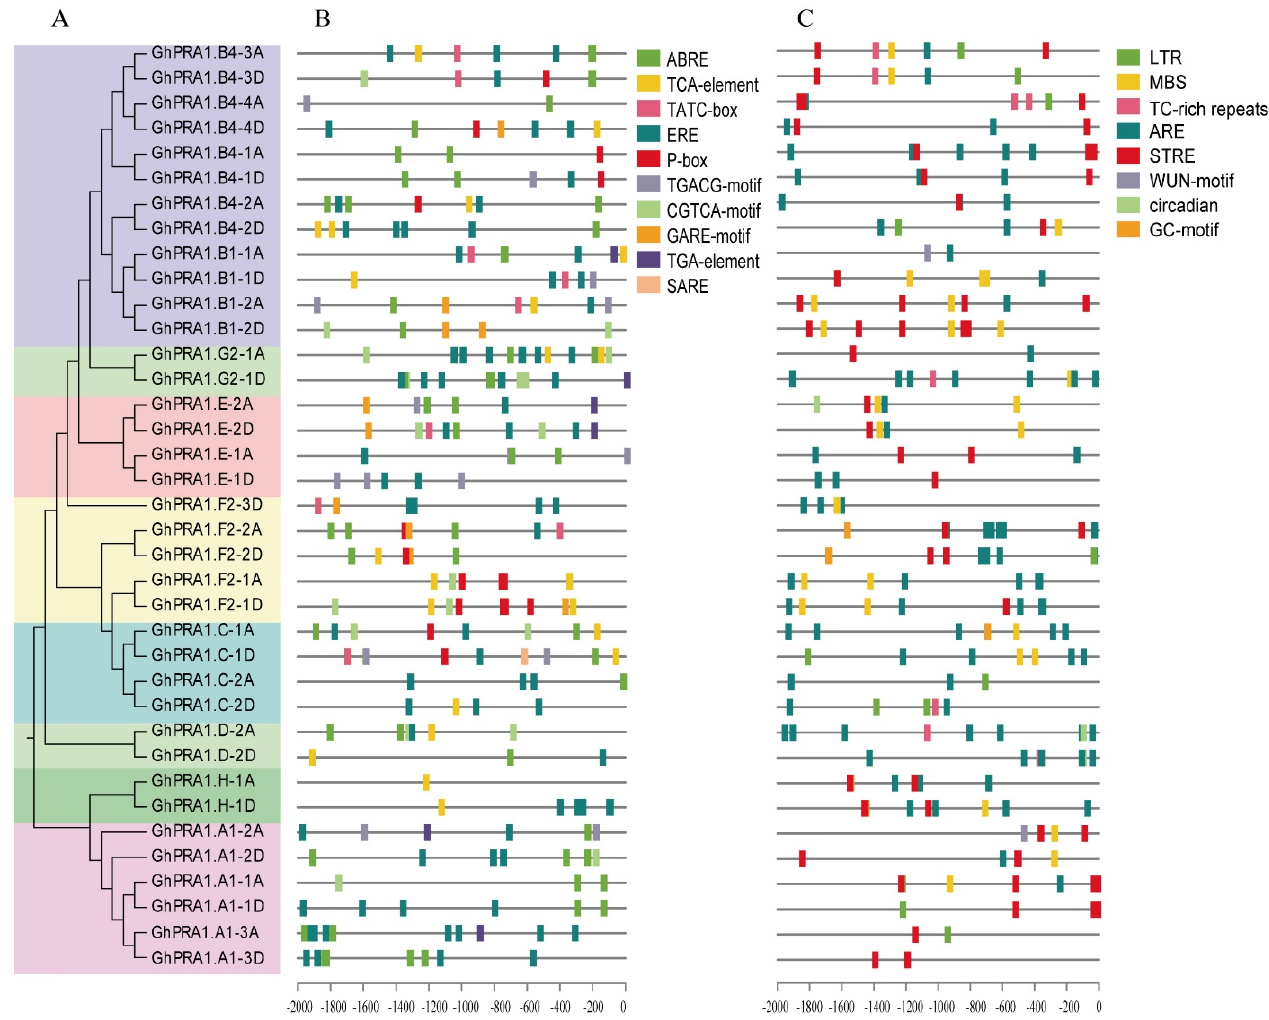
Figure 3. cis -elements in GhPRA1 promoter regions. ( A ) Phylogenetic tree of GhPRA1 proteins. ( B ) Hormone response elements. ABRE, abscisic acid response element; P-box; TATC box; GARE motif, gibberellin response element; TCA element; SARE, salicylic acid responsiveness element; CGTCA motif; TGACG motif. MeJA response cis -regulating elements: ERE, ethylene response element; TGA element, auxin response element. ( C ) Environmental stress related elements: STRE, stress response element; ARE, anaerobic induction element; MBS, MYB drought induction binding site; LTR, low temperature response element; GC motif, anoxic specific inducibility enhancer-like element; circadian, cis -acting regulatory element involved in circadian rhythm regulation; WUN motif, wound-responsive element; TC-rich repeats, defense and stress response cis